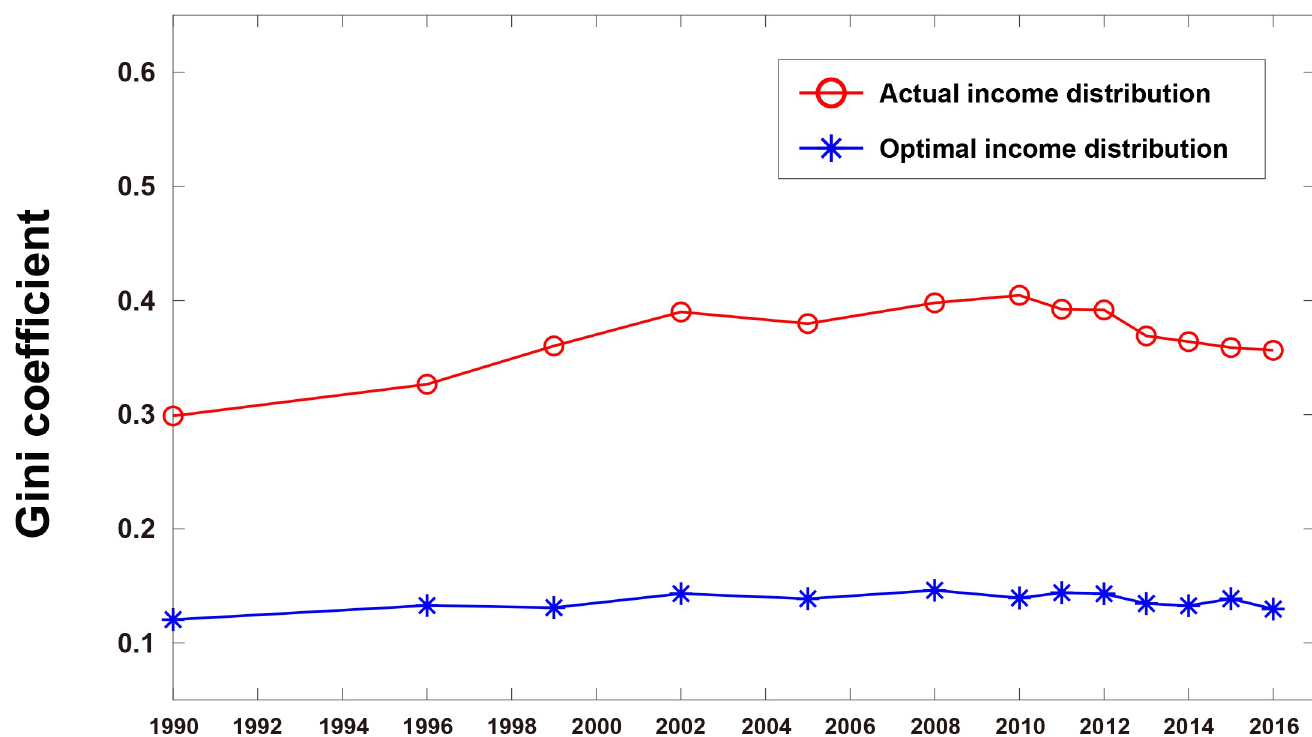
Fig 8. Evolution of Gini coefficients in China from 1990 to 2016. The Gini coefficient values at the data points can be found in S3 Table.